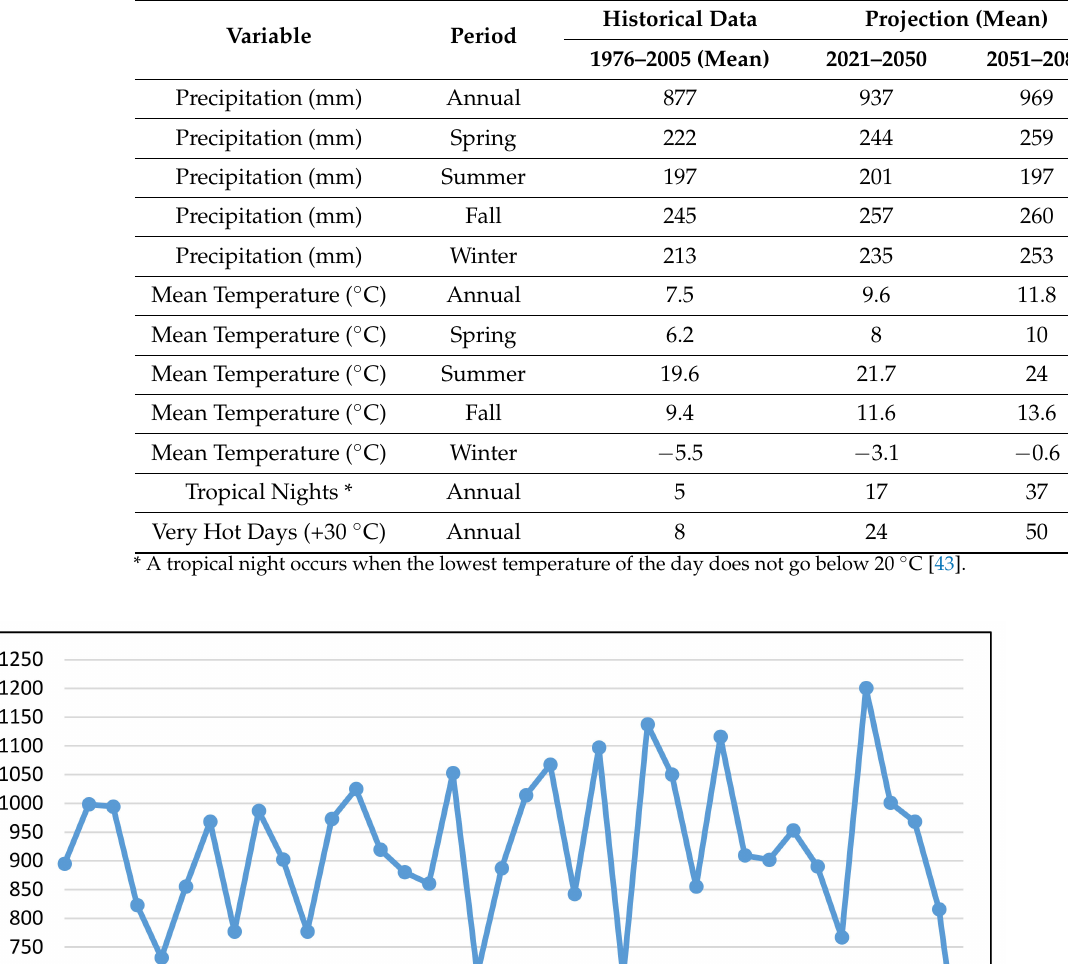
Table 4. Historical data and future climate projection (RCP8.5: high carbon climate scenario) for Prince Edward County. Adopted from Ref. [42].